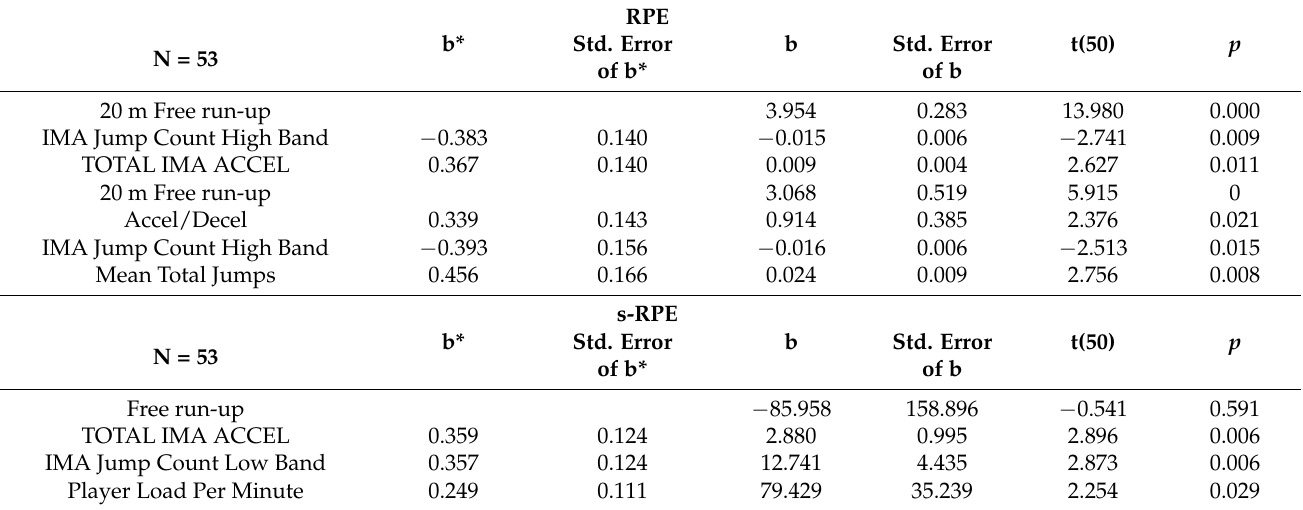
Table 6. Multiple regression models for